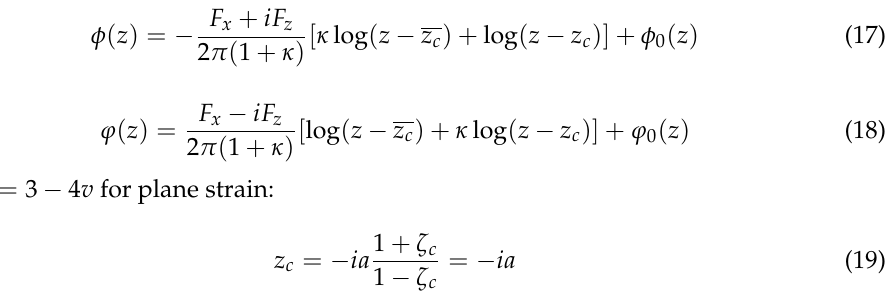
Figure 6.  -plane of conformal mapping. Figure 6. ζ -plane of conformal mapping. During tunnel excavation, the removal of soil will be synchronized by the generation of concentrated forces F x and F z around the tunnel periphery, both of which are equal to the weight of excavated soil minus the weight of the tunnel lining. The “buoyancy effect” will occur when the weight of excavated soil is greater than the lining [15,40], and is incorporated into the method in this study by using the complex potential functions of Equations (17) and